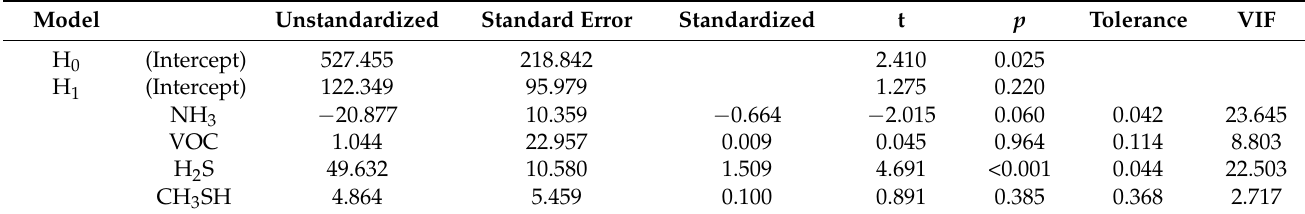
Table 4. Model coefficients with collinearity statistics.